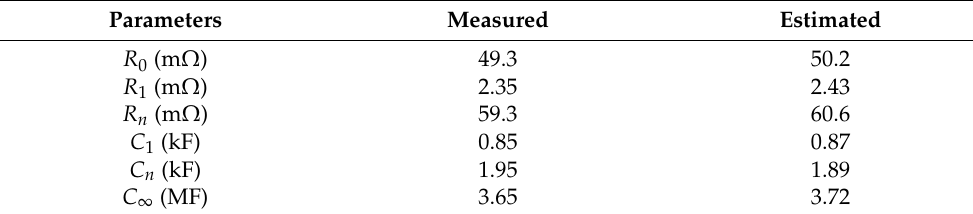
Table 15. Results of Case 8.